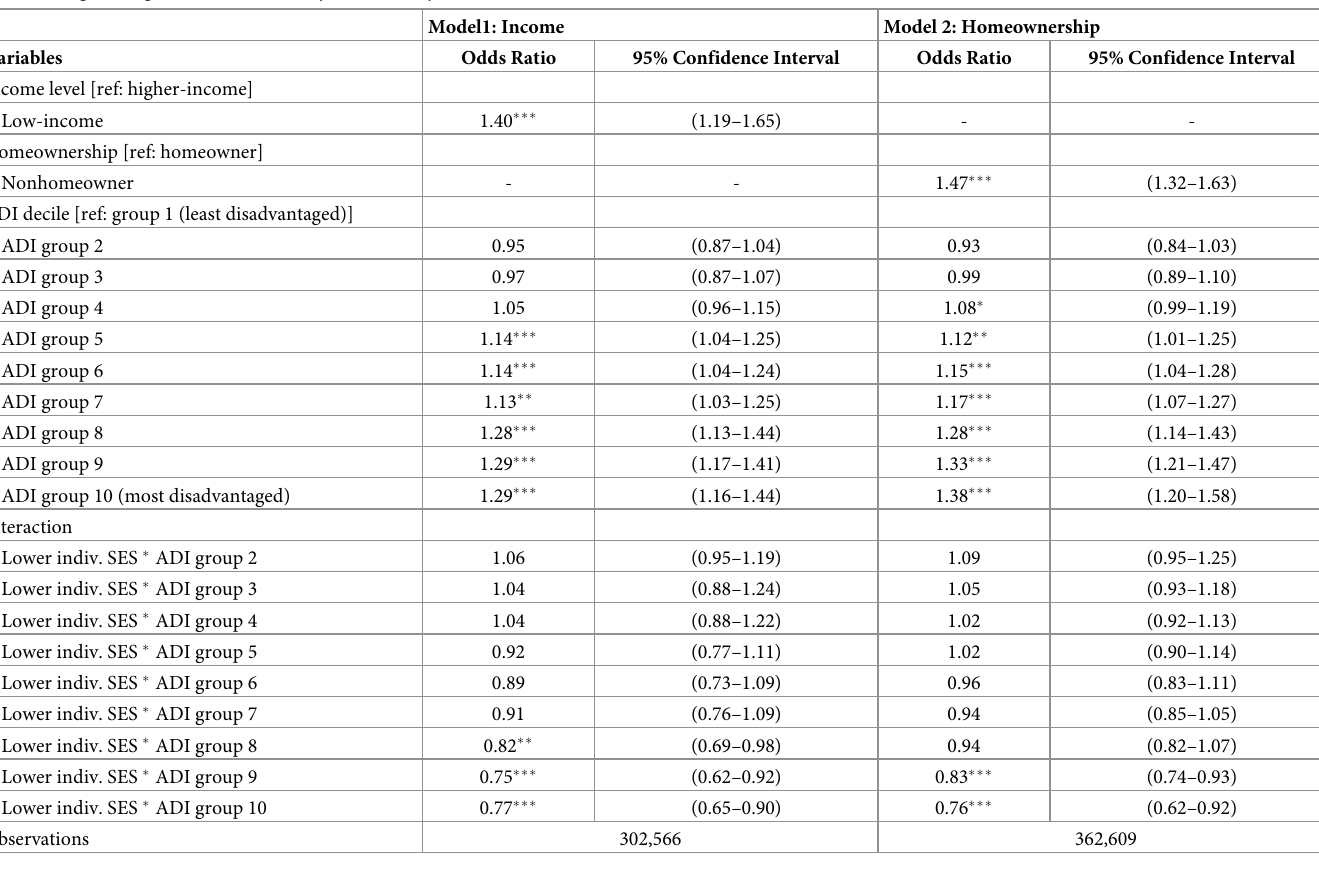
Table 2. Logistic regression results on 2-year